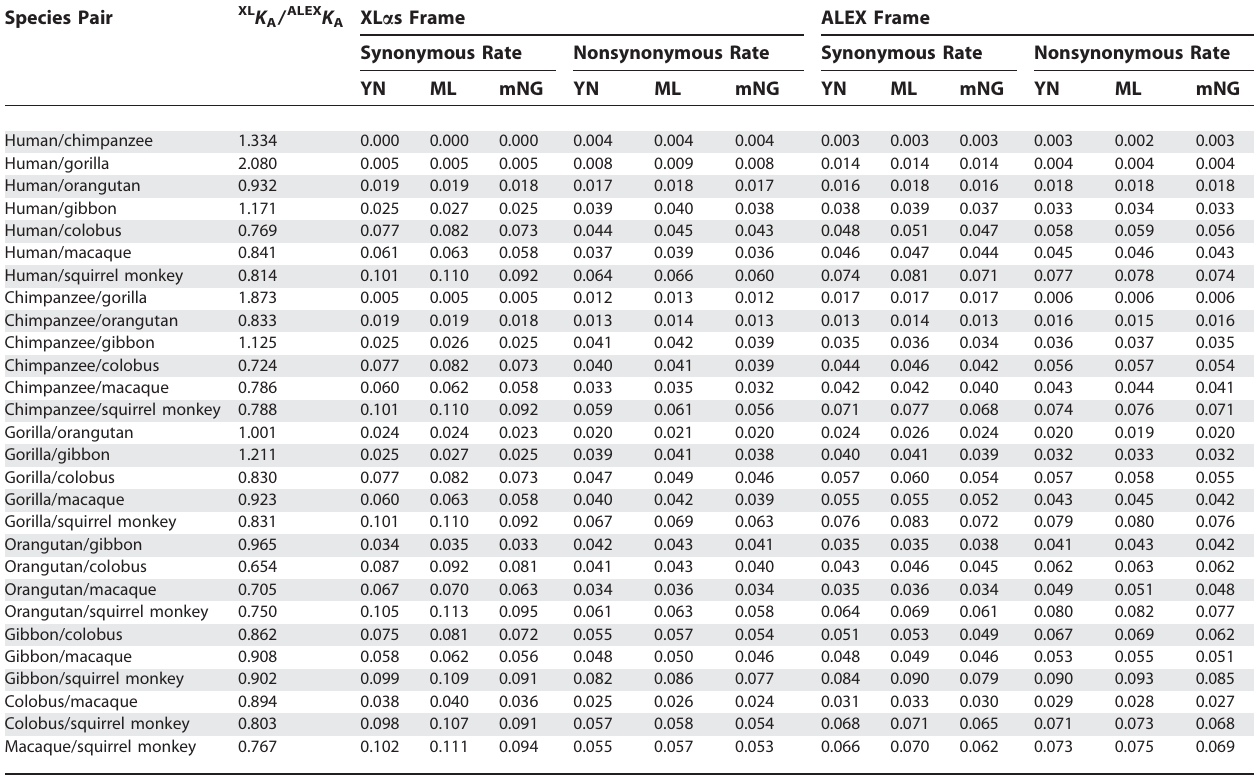
Table 1. Pairwise Synonymous and Nonsynonymous Rates in XL a s and ALEX Protein-Coding Regions Species Pair